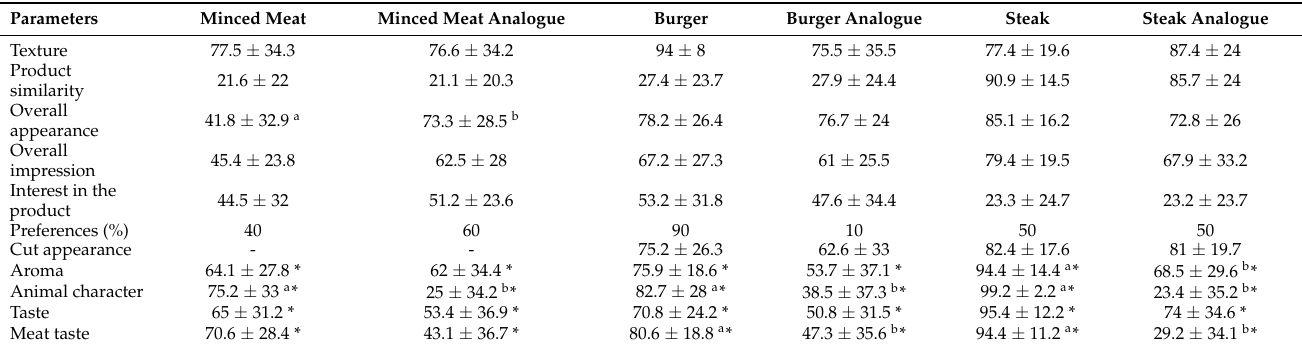
Table 3. Sensorial attributes of minced meat, burger, steak and their analogue